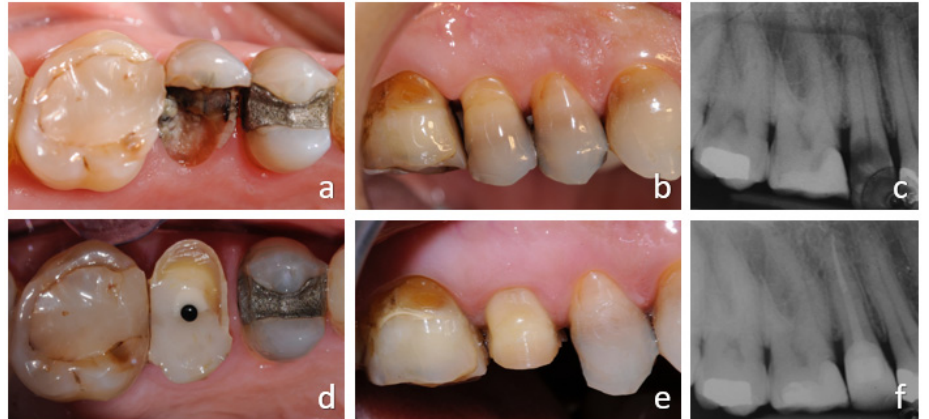
Figure 1. Orthodontic extrusion of tooth 1.5 with insufficient ferrule effect. Preoperative clinical occlusal and vestibular views and radiograph ( a – c ): tooth with deep caries. Endodontic treatment and post-endodontic restoration with post was performed: occlusal and buccal views and post-operative radiograph ( d – f ).